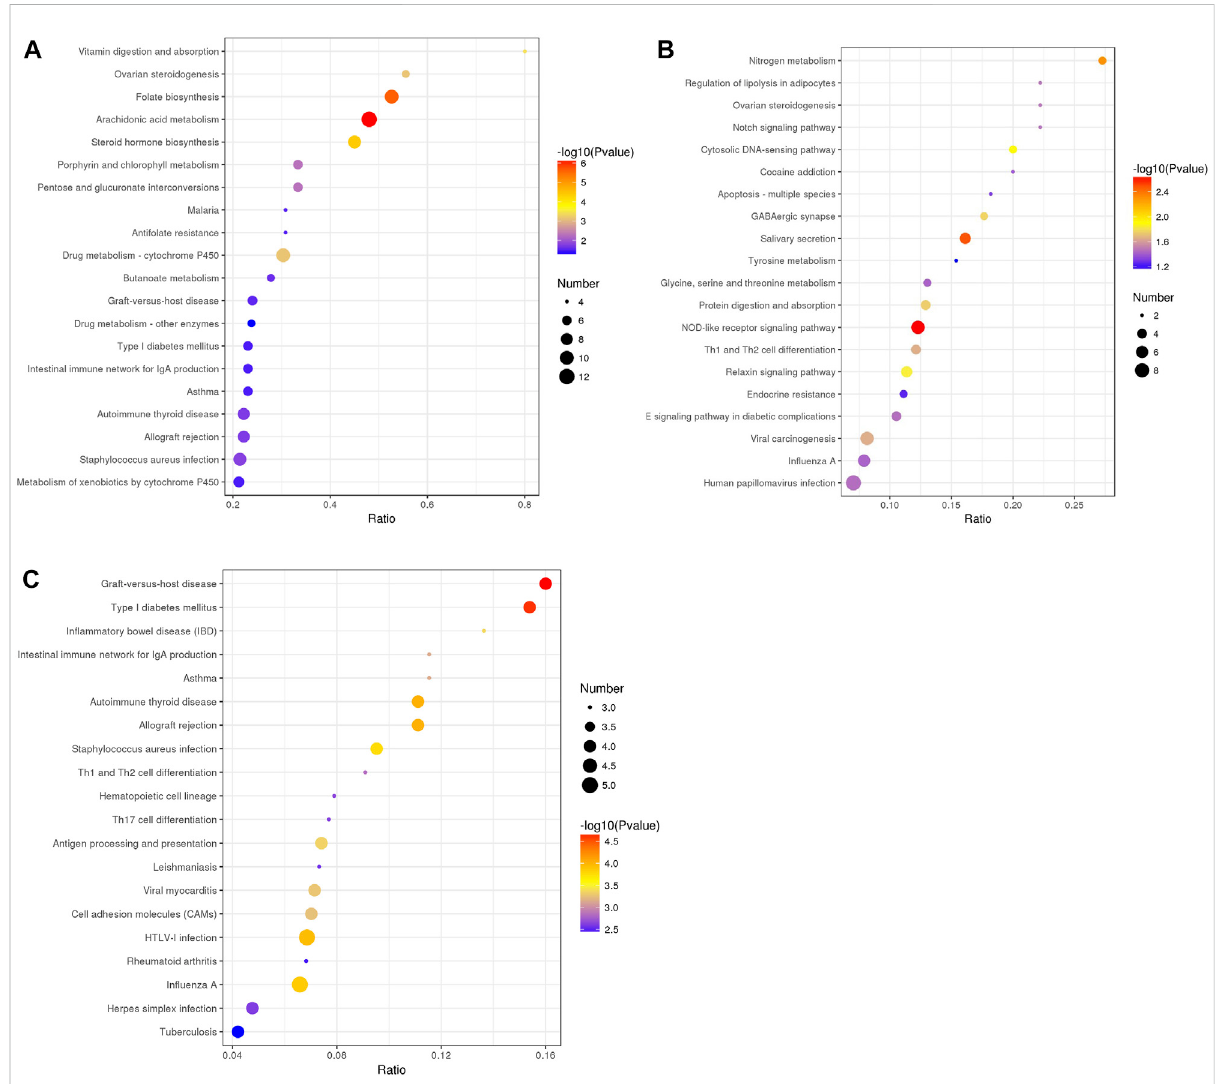
FIGURE 6 KEGGpathwayenrichmentanalysisofdifferentiallyabundantproteinsinrumenepitheliumbetween (A) day0andday30, (B) day30andday60, and (C) day 60 and day 90 of age. All pathways are listed according to p